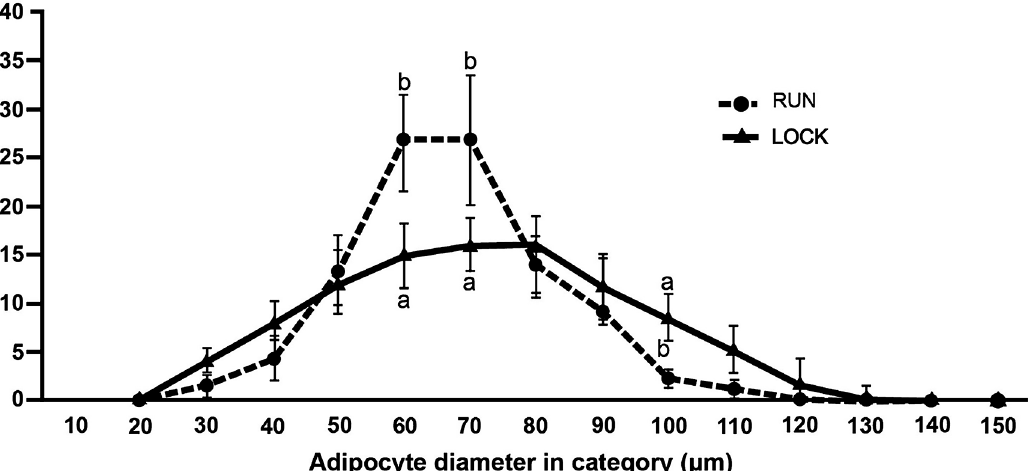
Fig 3. PRAT adipocyte size distribution. Adipocyte diameters were classified in 10- μ m categories [category #, adipocyte diameter range in μ m (10: 0.0 – 9.0 μ m, 20: 10.0 – 19.9 μ m, 20: 20.0 – 29.9 μ m, etc.] on the x-axis; and the percentage of total adipocytes in a 10- μ m category was plotted on y-axis. At least 300 adipocyte diameters were measured for each tissue sample. Different letters denote differences among groups at each 10- μ m category, p < 0.05, as determined by Student ’ s t-test.